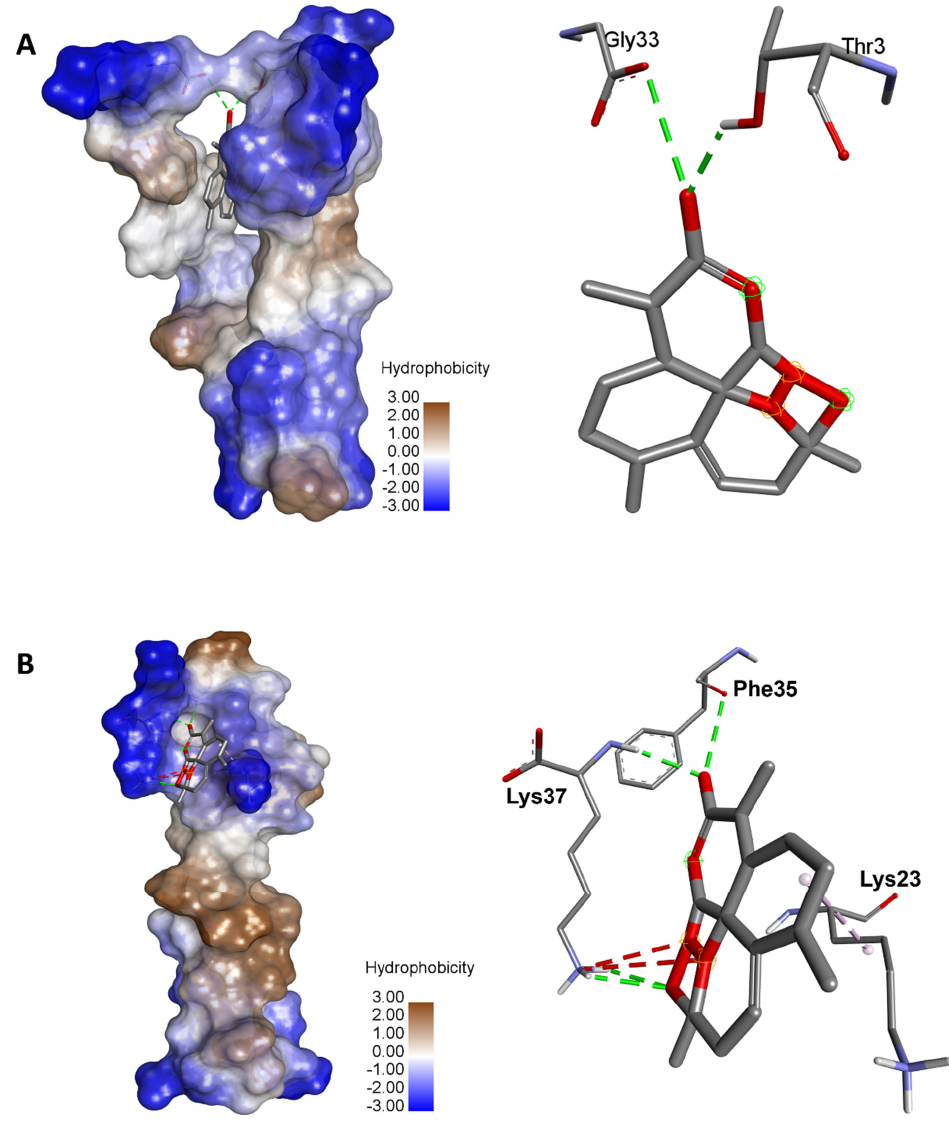
Figure 4. Illustration of the 3D complexes of ACE2 and artemisinin (left) and the artemisinin interactions with the amino acid residues (right). ( A ) Variant 8 of ACE2 (rs961360700) with the highest binding energy (–8.2 kcal/mol). ( B ) Variant 10 of ACE2 (rs1316056737) with the highest number of hydrogen bonds ( n =